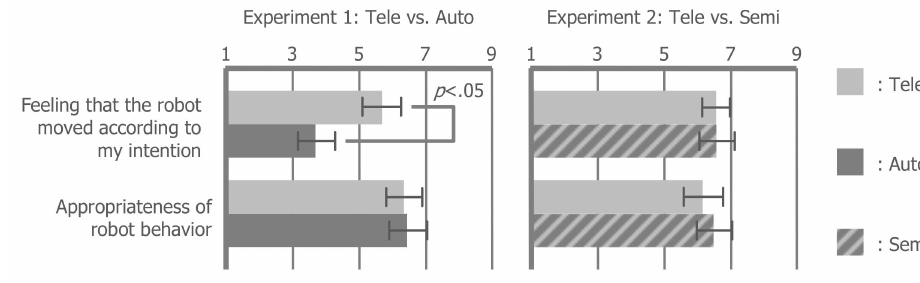
Figure 7. Results of measuring